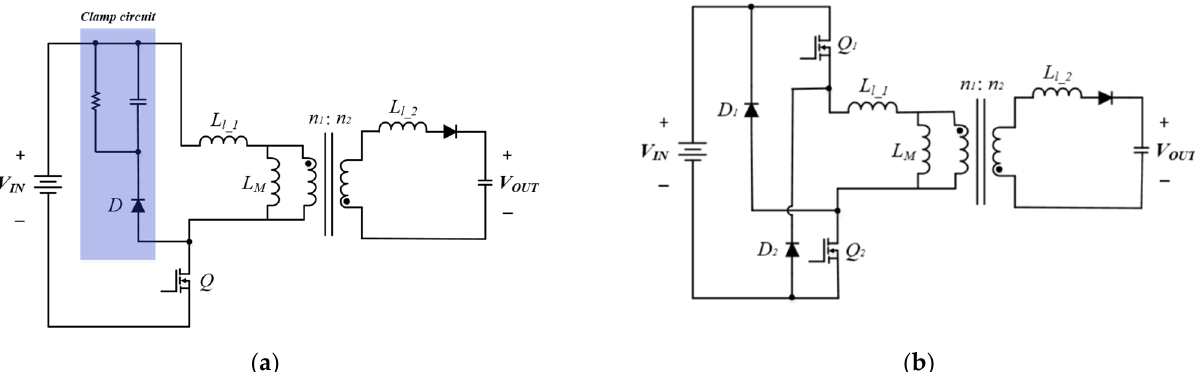
Figure 3. Two flyback converter with one switch. ( a ) one-switch flyback converter with clamp circuit; ( b ) two-switch flyback converter with clamp circuit.